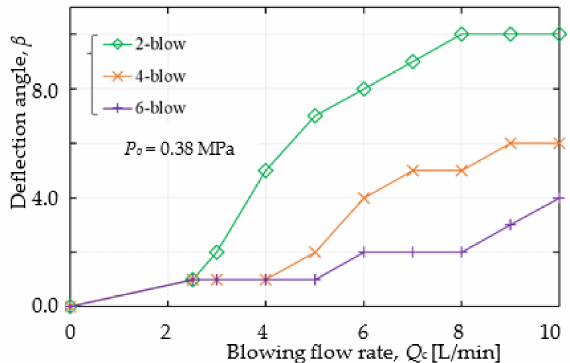
Figure 12. Deflection angle, β and blowing flow rate, Q c ( P 0 = 0.38 MPa): The deflection angle increases as Q c increases, and β also increases as the number of blowing nozzle n b decreases. 2. Effect of the Number of Blowing Nozzles, n b , on the Deflection Angle β Figure 13 indicates the relation between β and n b . The deflection angle has a maximum value of β = 10 ◦ at n b = 2, and in the 4 − , 6 − , and 8 − blow cases, the deflected angles are 6 ◦ , 4 ◦ , and 0 ◦ , respectively.